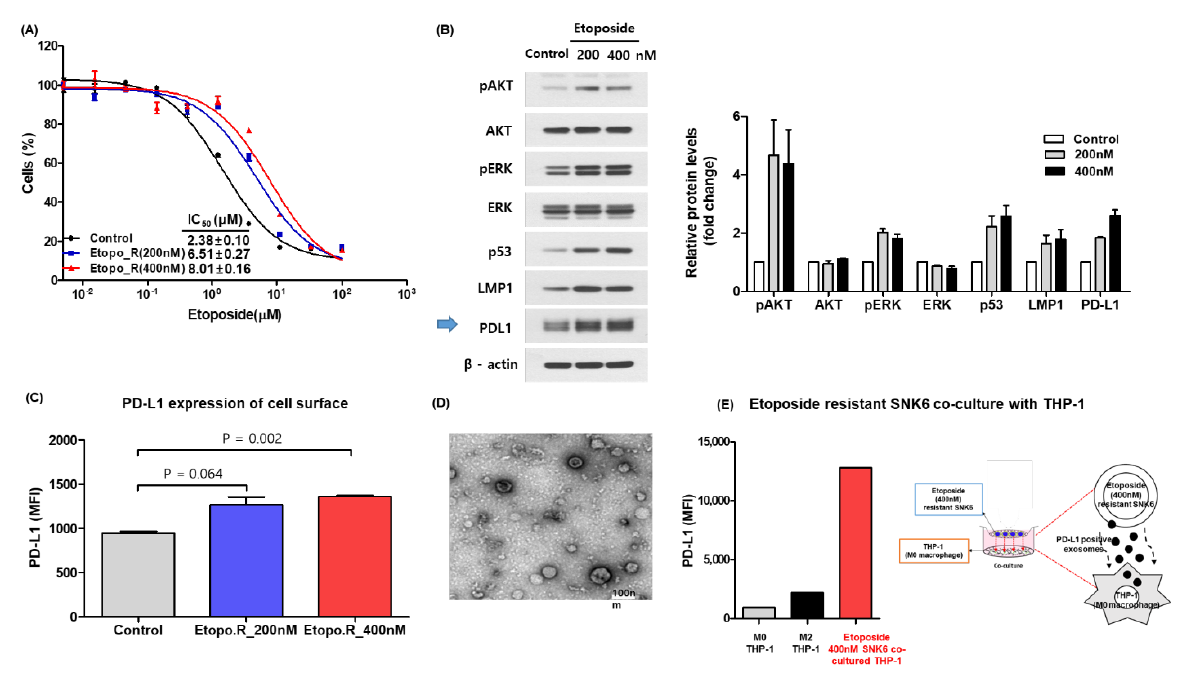
Figure 1. ( A ) Development of etoposide-resistant SNK6R cells. ( B ) Increased expression of PD-L1 in etoposide-resistant SNK6R cells. The original blots could be found in Figure S2. ( C ) Increased expression of PD-L1 on the surfaces of SNK6R cells. ( D ) Transmission electron microscopy identifies exosomes. ( E ) Co-culturing of SNK6R cells with a macrophage cell line (THP-1) reveals an increase in PD-L1.